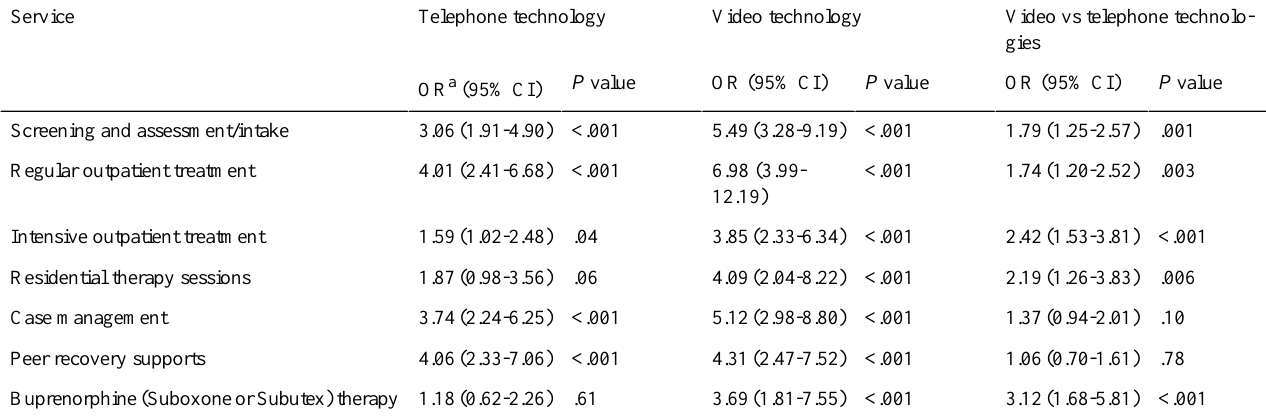
Table 2. Odds of using telehealth post